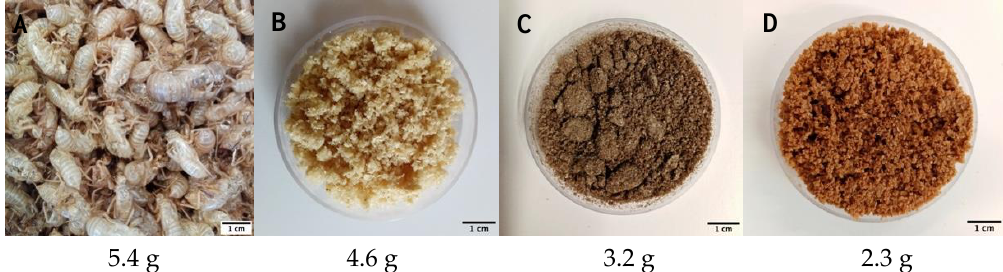
Figure 1. Schematic illustration of the raw material and all the other samples after the extraction steps. The weight of the raw material ( A ) after washing and drying it in the oven at 50 °C for 24 h was 5.4 g. The weight of dried demineralized ( B ), deproteinized ( C ), and decolorized samples (chitin- D ) was 4.6, 3.2, and 2.3 g, respectively.